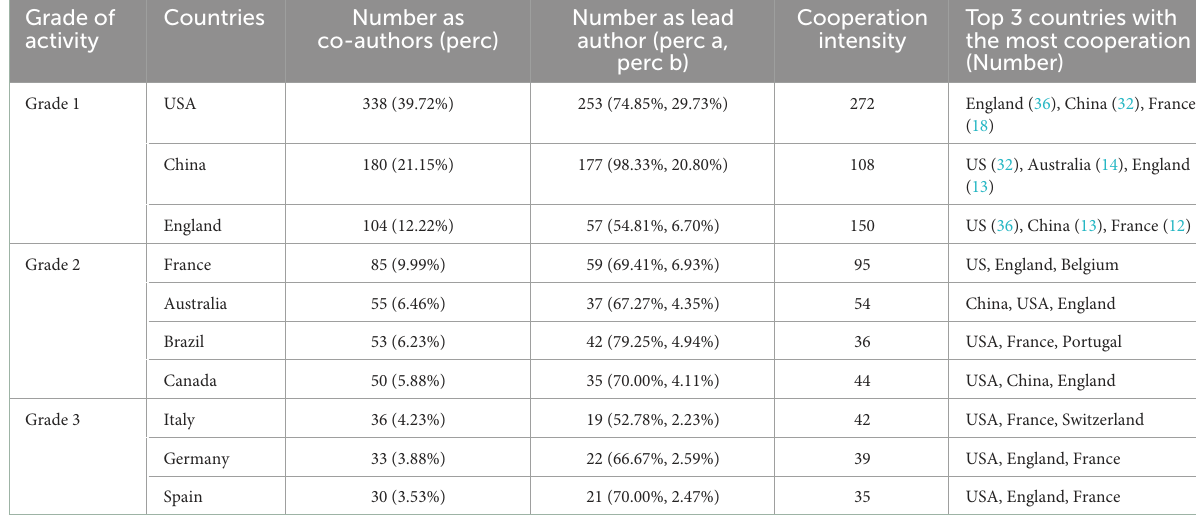
TABLE 3 Top 10 number of publications and collaboration.